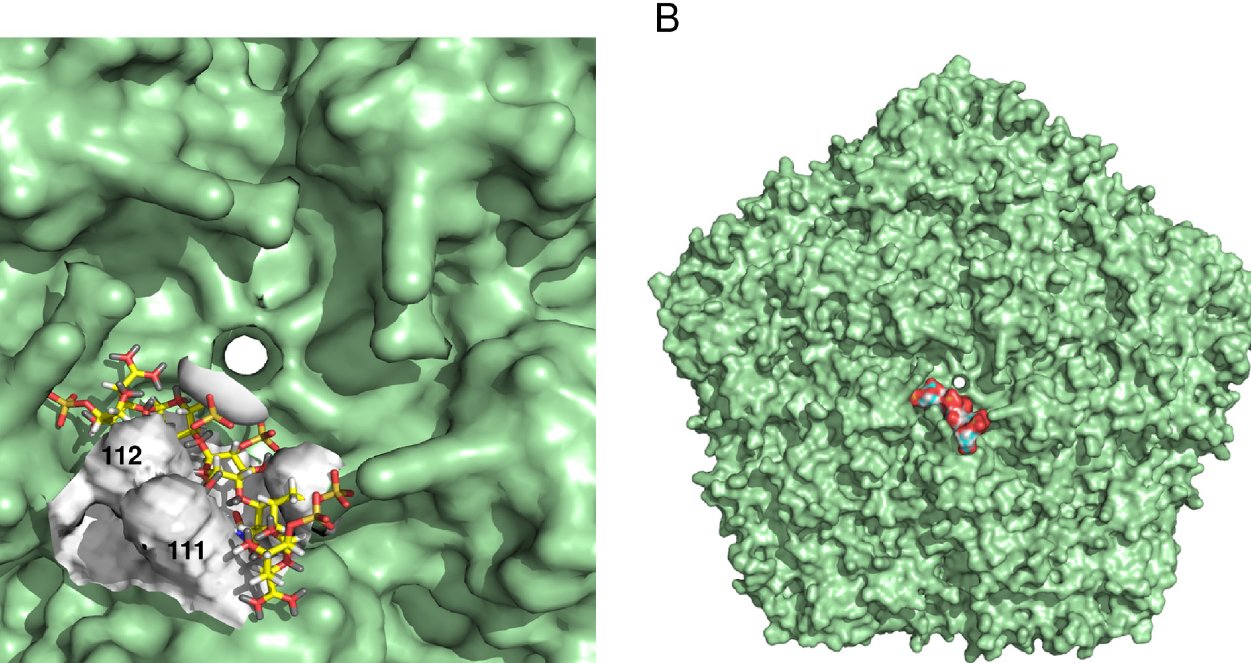
PLOS Pathogens| https://doi.org/10.1371/journal.ppat.1008828 September 29,